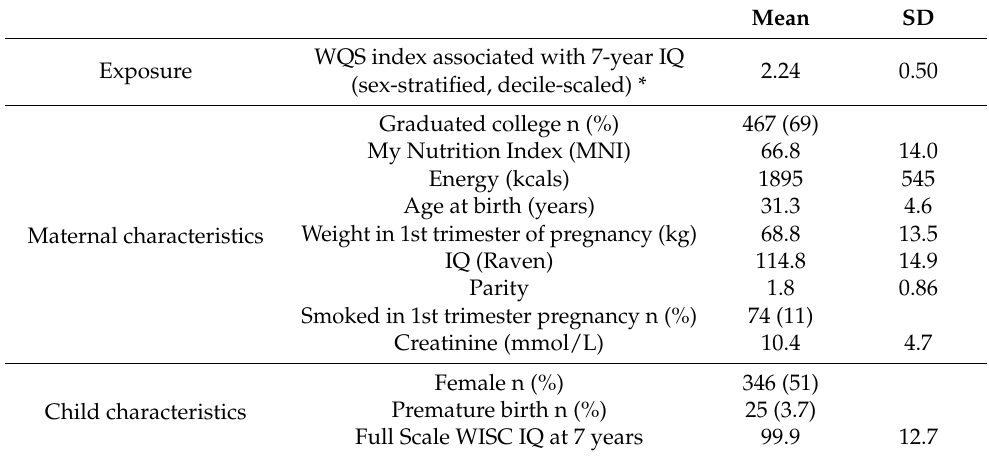
Table 1. Summary statistics of population characteristics using the SELMA pregnancy cohort (N = 678). (*) The WQS index is derived from a WQS sex-stratified interaction model of 26 EDCs associated with child IQ at 7 years of age, adjusted by covariates.